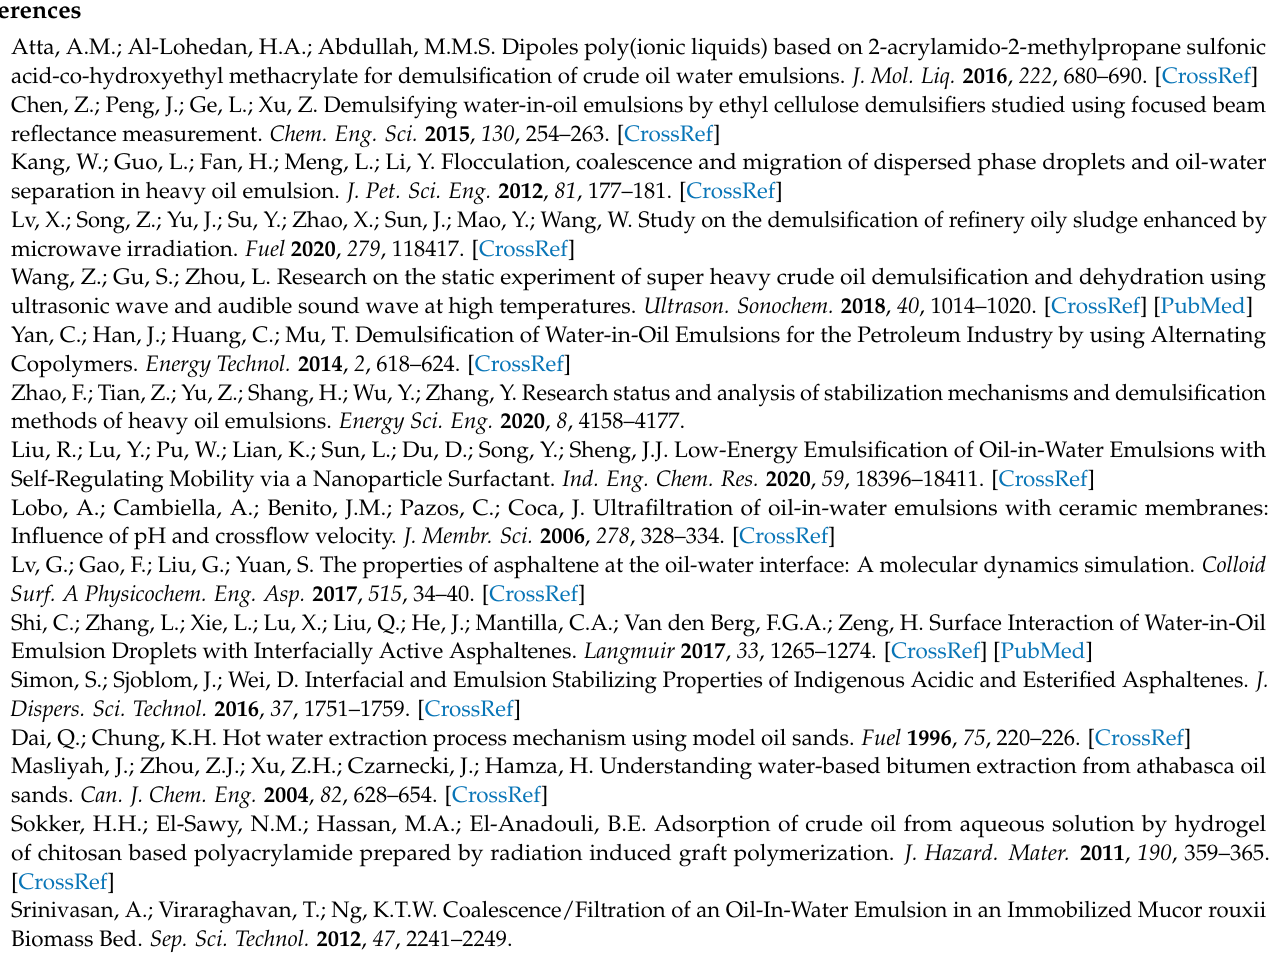
Table S1: Compositions of the crude oil